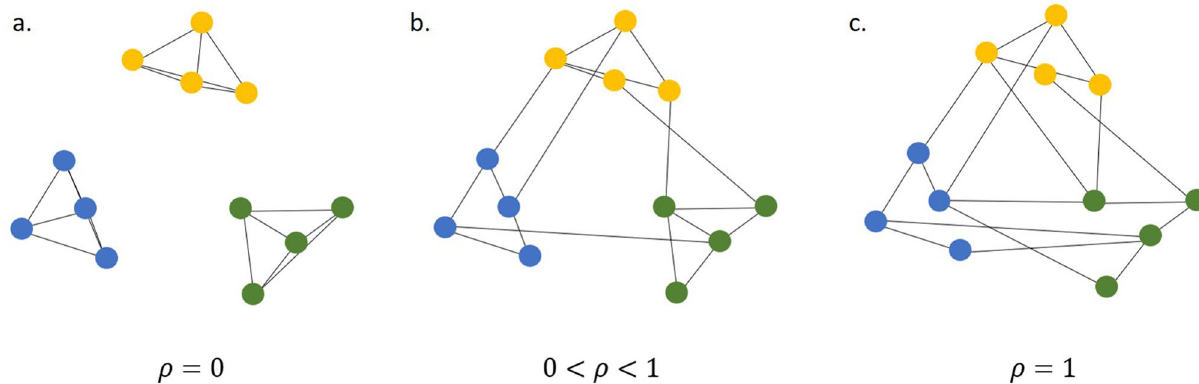
Figure 2. Illustration of the effect of ρ on network structure using a toy synthetic network. Synthetic co-exposure networks at 3 values of ρ are shown. The colors denote the types of media outlets. When ρ = 0 , all agents visit outlets of the same type as themselves, creating zero co-exposure between different types of outlets ( Panel a ). When 0 < ρ < 1 , all agents visit a fraction ( = ρ ) of the outlets they visit, randomly, and the remaining fraction ( = 1 − ρ ), selectively, i.e. of the same type as themselves. This creates some connections of co-exposure between outlets of different types ( Panel b ). As ρ is increased, the number of connections between different types of media outlets increases, as the agents’ behavior becomes less selective, and more random. When ρ = 1 , all agents visit all the outlets they visit, randomly, creating instances of co-exposure between outlets of different types as likely as instances of co-exposure between outlets of the same type ( Panel c